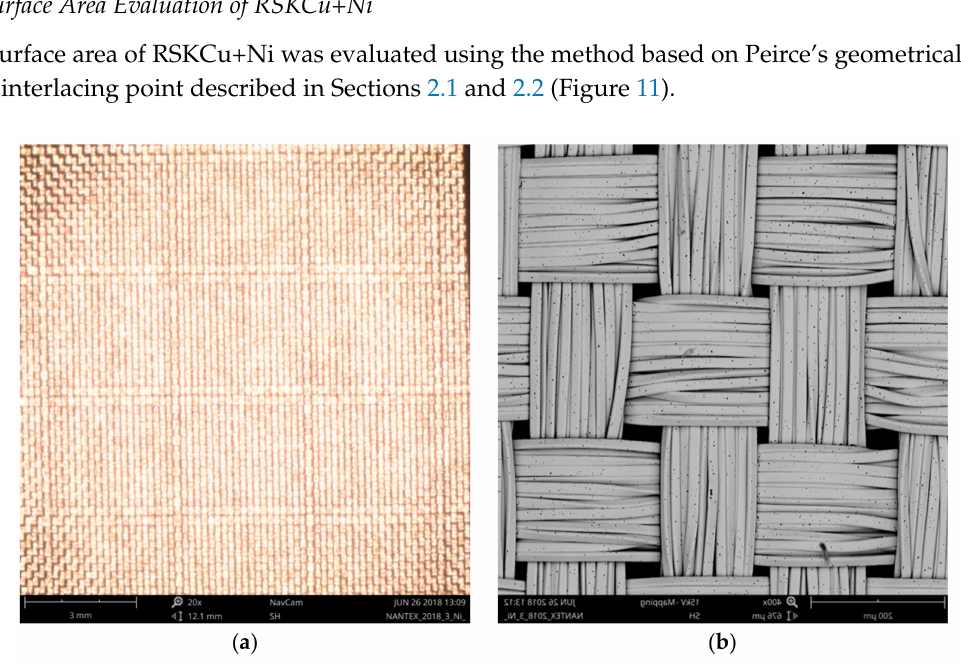
Figure 11. A sample of RSKCu+Ni ( a ), and detail of the sample structure ( b